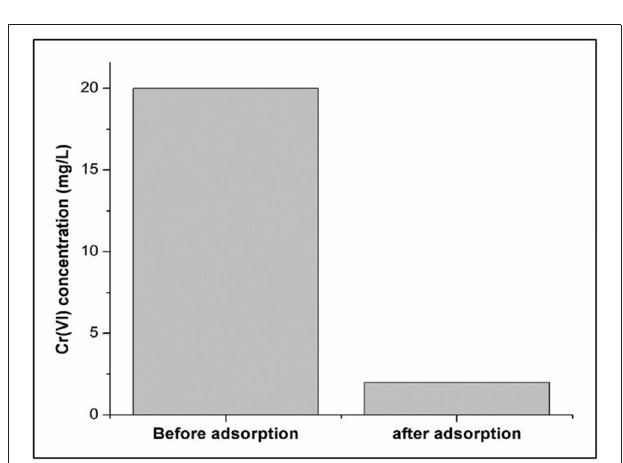
FIGURE 12 | Cr(VI) adsorption by Fe 3 O 4 /FMO from real water